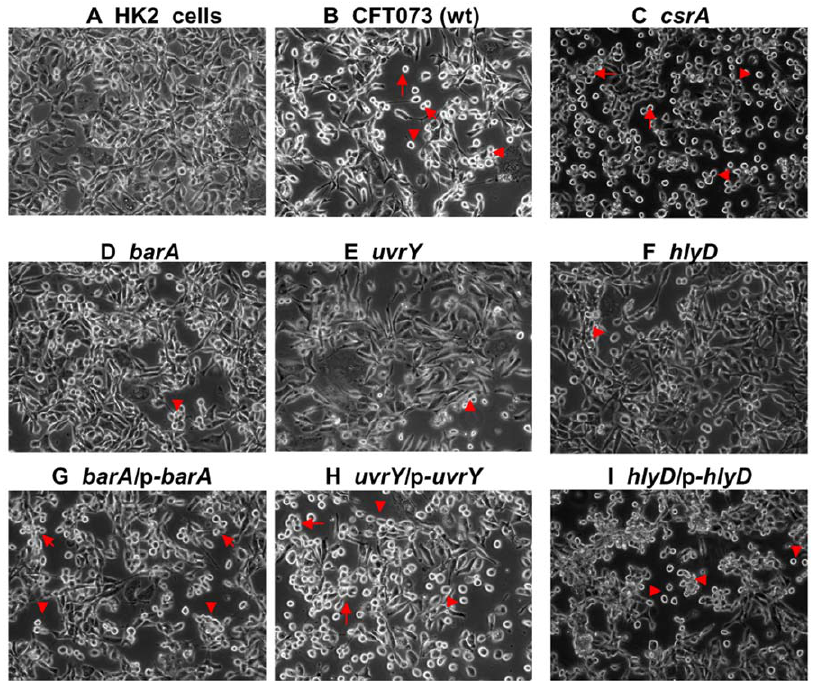
Figure 3. Phase-contrast photomicrographs of human kidney (HK-2) cells. Photomicrographs were taken 6 hr later from either untreated control (HK-2 cells) (A), or treated with supernatants from CFT073 WT (B), csrA (C), barA (D), uvrY (E), hlyD (F), barA /p- barA (G), uvrY /p- uvrY (H) and hlyD /p -hlyD (I). The rounding and detachment of cells in the treated monolayer are marked with arrow or arrowhead. The pictures were representative of three individual